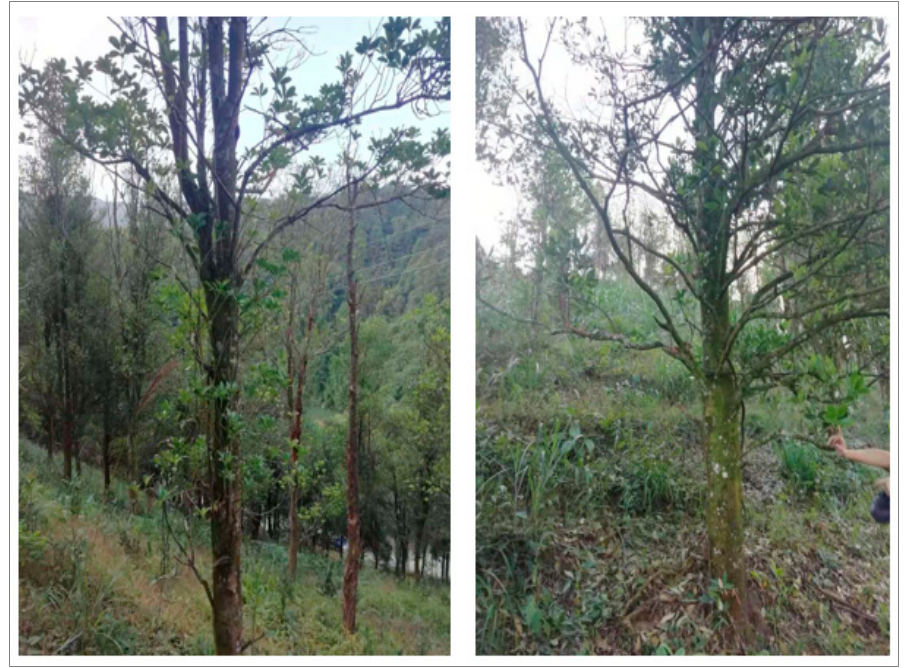
Figure 3. Location map of sampling center of partial field Illicium verum .